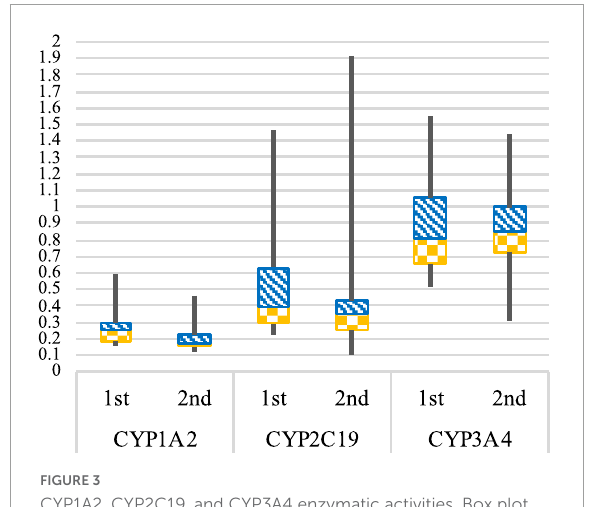
FIGURE3 CYP1A2, CYP2C19, and CYP3A4 enzymatic activities. Box plot representing the CYP1A2, CYP2C19, and CYP3A4 metabolic ratios at 1st and 2nd blood sampling. Geneva cocktail reference values (–SD to + SD): CYP1A2 = PM (poor metabolizer) 0.03–0.204; EM (normal metabolizer) 0.17–0.39; UM (ultra-metabolizer) 0.42–0.70. CYP2C19 = PM (poor metabolizer) 0.08–0.28; EM (normal metabolizer) 0.3–1.22; UM (ultra-metabolizer) 2.96–7.88. CYP3A4 = PM (poor metabolizer) 0.15–0.29; EM (normal metabolizer) 0.32–0.82; UM (ultra-metabolizer) 2.21–5.25. For CYP2C9, CYP2B6, and CYP2D6 graphics in Supplementary Figures B1, B2